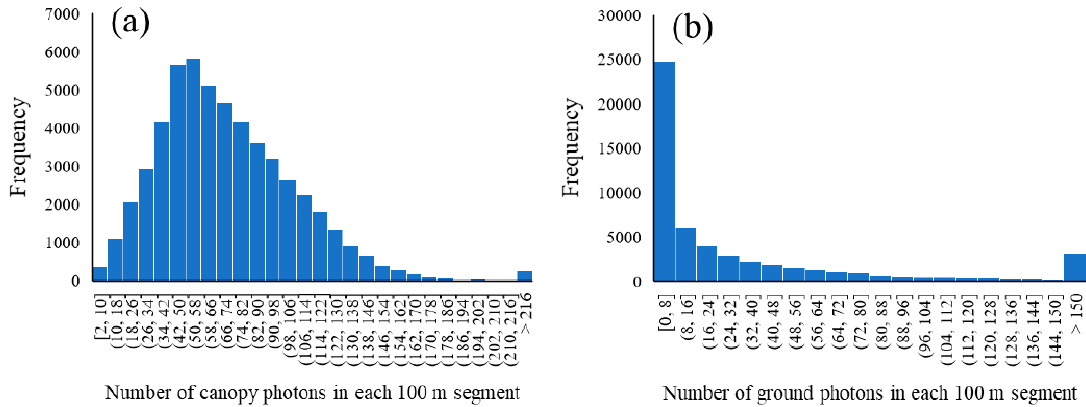
Figure 12. Frequency statistics histogram of canopy and ground photons. The x -axis in ( a , b ) represents the number range of signal photons (canopy and ground photons), and the y -axis in ( a , b ) represents the frequency of signal photons within 100 m segments of all ATL08 records in the study area.